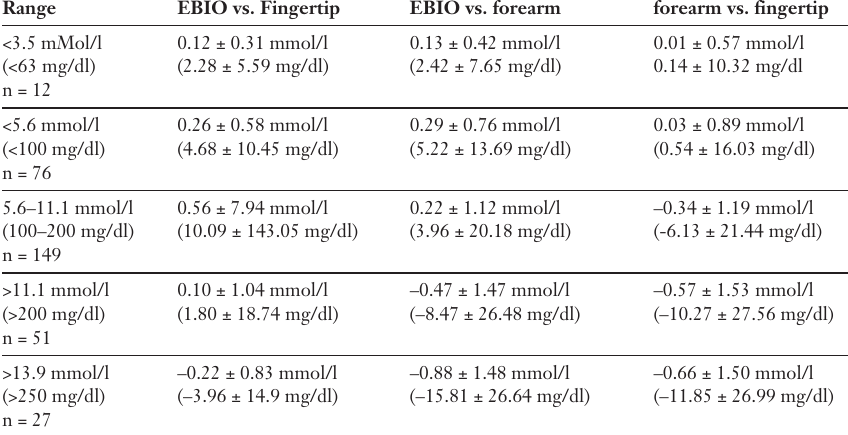
Mean deviations after the stratification into the three mea- surement ranges and for the hypo- glycemic (<3.5 mmol) and hyperglycemic (>13.9 mmol)